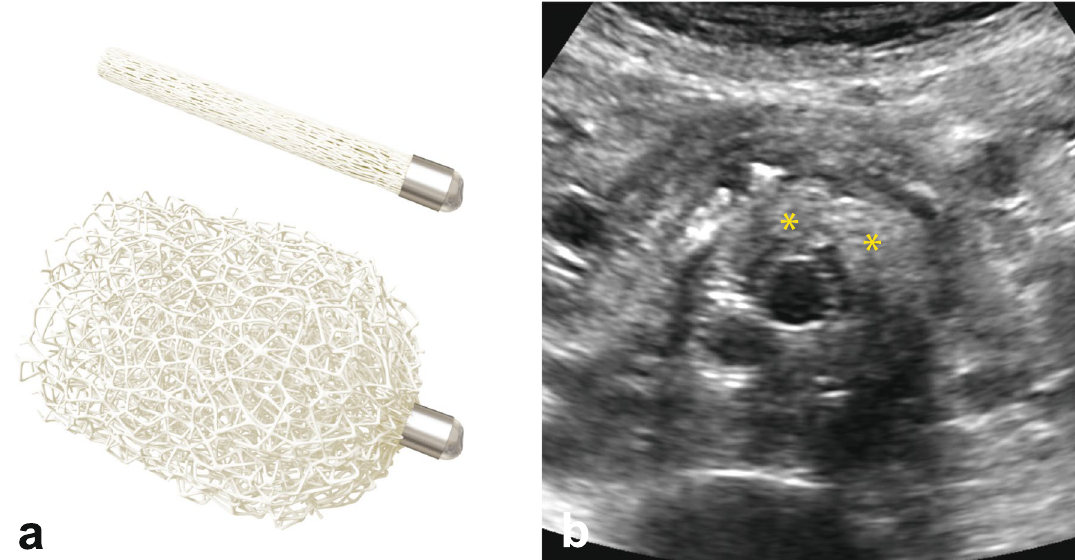
Fig. 2 a Illustration of the implanted shape memory polymer device in its crimped (above) and (below) expanded form. b The appearance of shape memory polymer devices under follow‑up ultrasound (yellow asterisks indicate location of some polymer). A video of shape memory polymer device deployment illustrating the appearance under fluoroscopy is shown in the supplementary